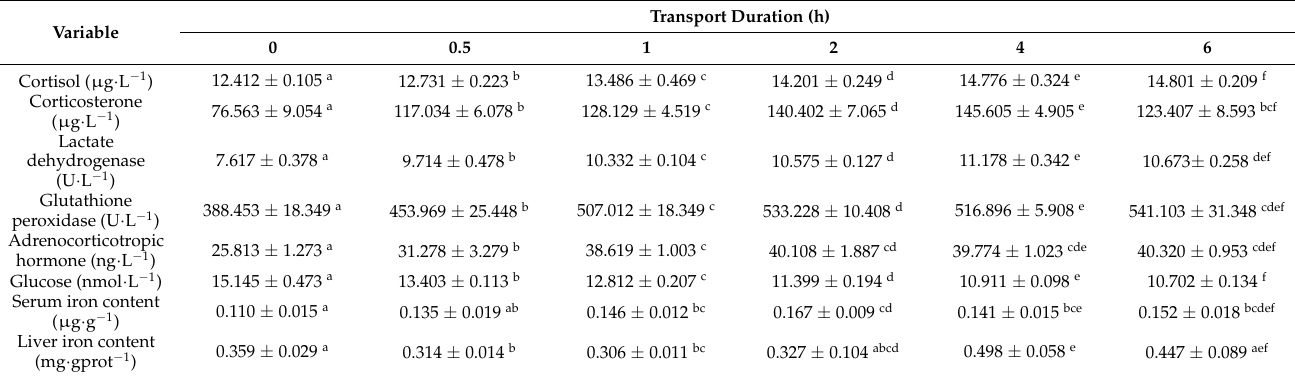
Table 1. Changes in blood biochemistry and liver iron content of broilers in the transport model